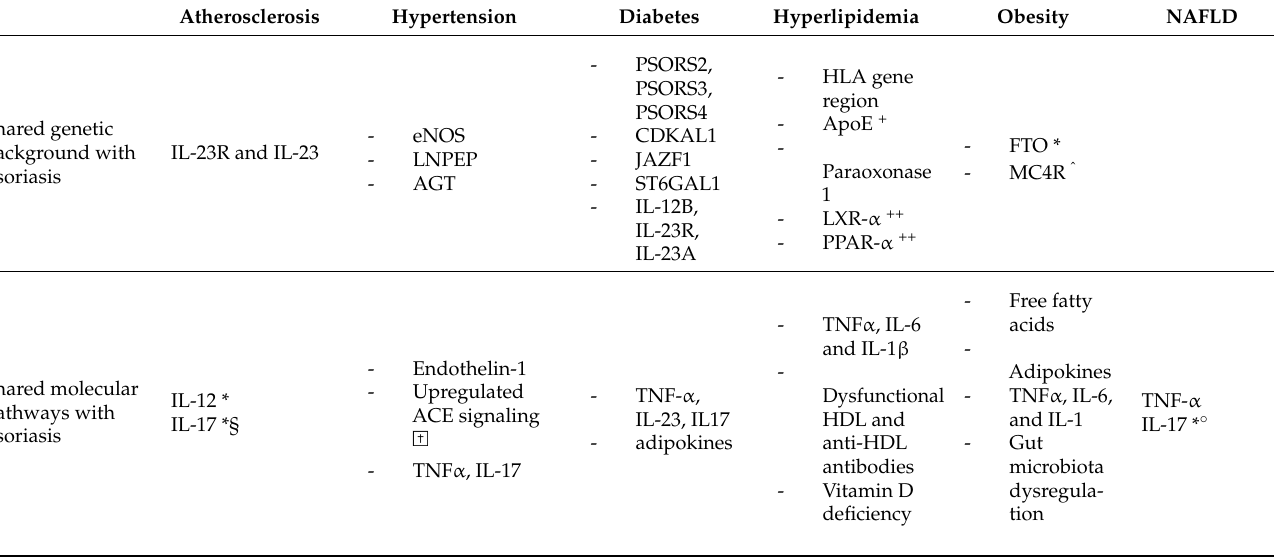
Table 1. List of the shared genetic and molecular pathways between psoriasis and CV events or CV risk